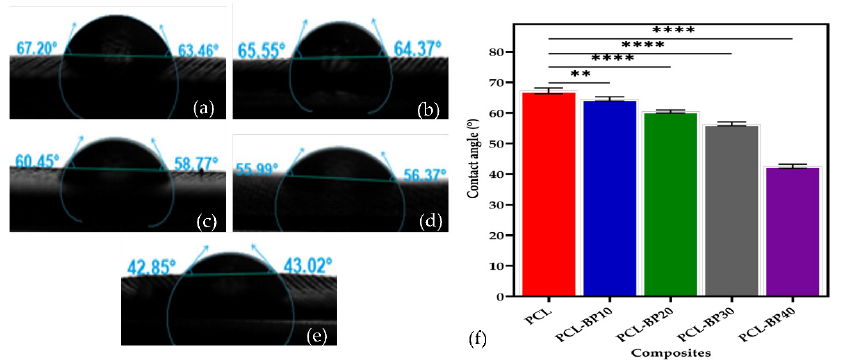
Figure 5. Sessile drop images of the PCL and its composites; ( a ) PCL; ( b ) PCL-BP10; ( c ) PCL-BP20; ( d ) PCL-BP30; ( e ) PCL-BP40; and ( f ) the contact angle measurements ( n = 3, ** p ≤ 0.01, **** p ≤